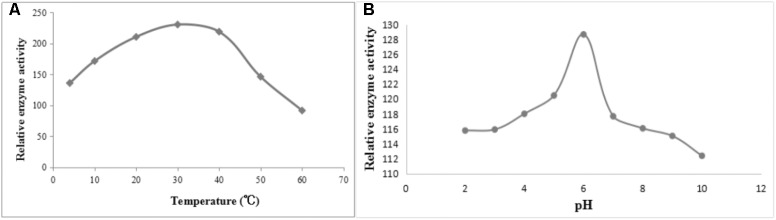
Determination of enzyme activity of recombinant protein. (A) Effect of temperature on the enzyme activity of recombinant protein. (B) Effect of pH on the enzyme activity of recombinant protein.